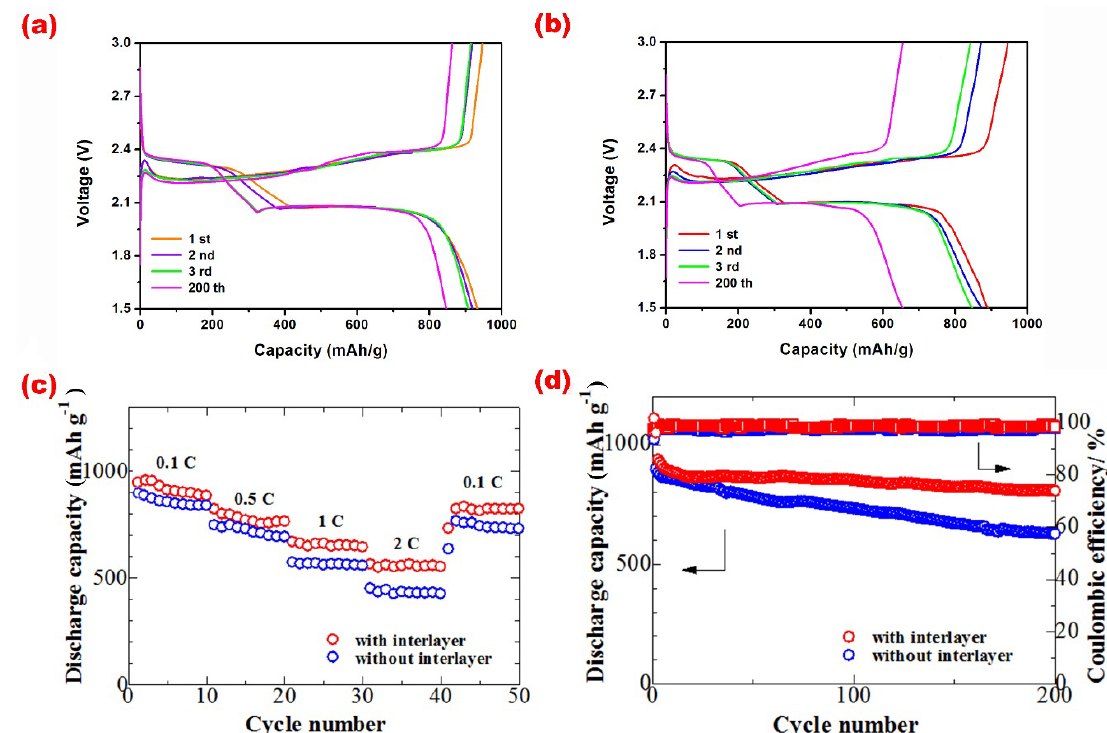
Figure 5. Charge/discharge voltage-capacity profiles of the cell ( a ) with and ( b ) without the ZnO/NDG composite-coated separator. ( c ) Rate performance of the cell with and without the ZnO/NDG composite-coated separator. ( d ) Cycling performance and Coulombic efficiency of the cell with the ZnO/NDG composite-coated